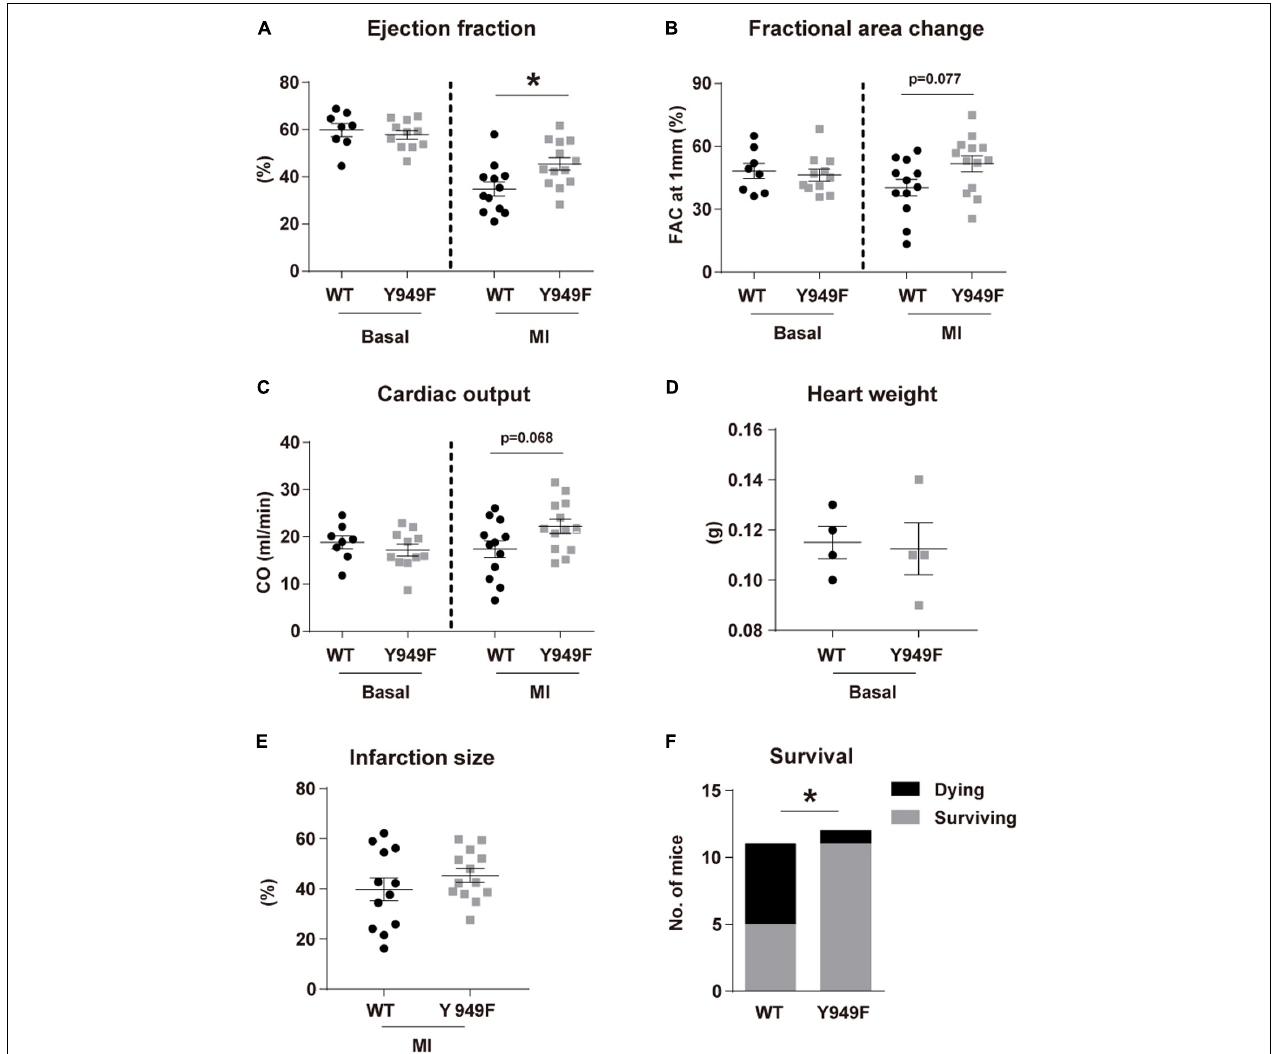
FIGURE 1 | Improved cardiac function following MI in Vegfr2 Y 949 F / Y 949 F mice. (A–C) Heart function assessed using echocardiography; (A) ejection fraction, (B) fractional area change (FAC), (C) cardiac output (CO) in Vegfr2 Y 949 F / Y 949 F mice and WT littermates in baseline condition ( n = 8–11 mice/strain), and at 24 h following myocardial infarction ( n = 12–13 mice/strain, conducted at three different occasions). (D,E) . Heart weights before infarction ( D ; n = 4 mice/strain) and induced infarct size at 24 h after ligation (E) ( n = 12–13 mice/strain) in WT and Vegfr2 Y 949 F / Y 949 F mice. Data in (A–E) are shown as mean ± SEM. Statistical significance was determined using Mann–Whitney test, * p < 0.05. (F) Survival after large infarct ( n = 11–12/strain). Chi-squared test; * p < 0.05. For all panels, n refers to biological